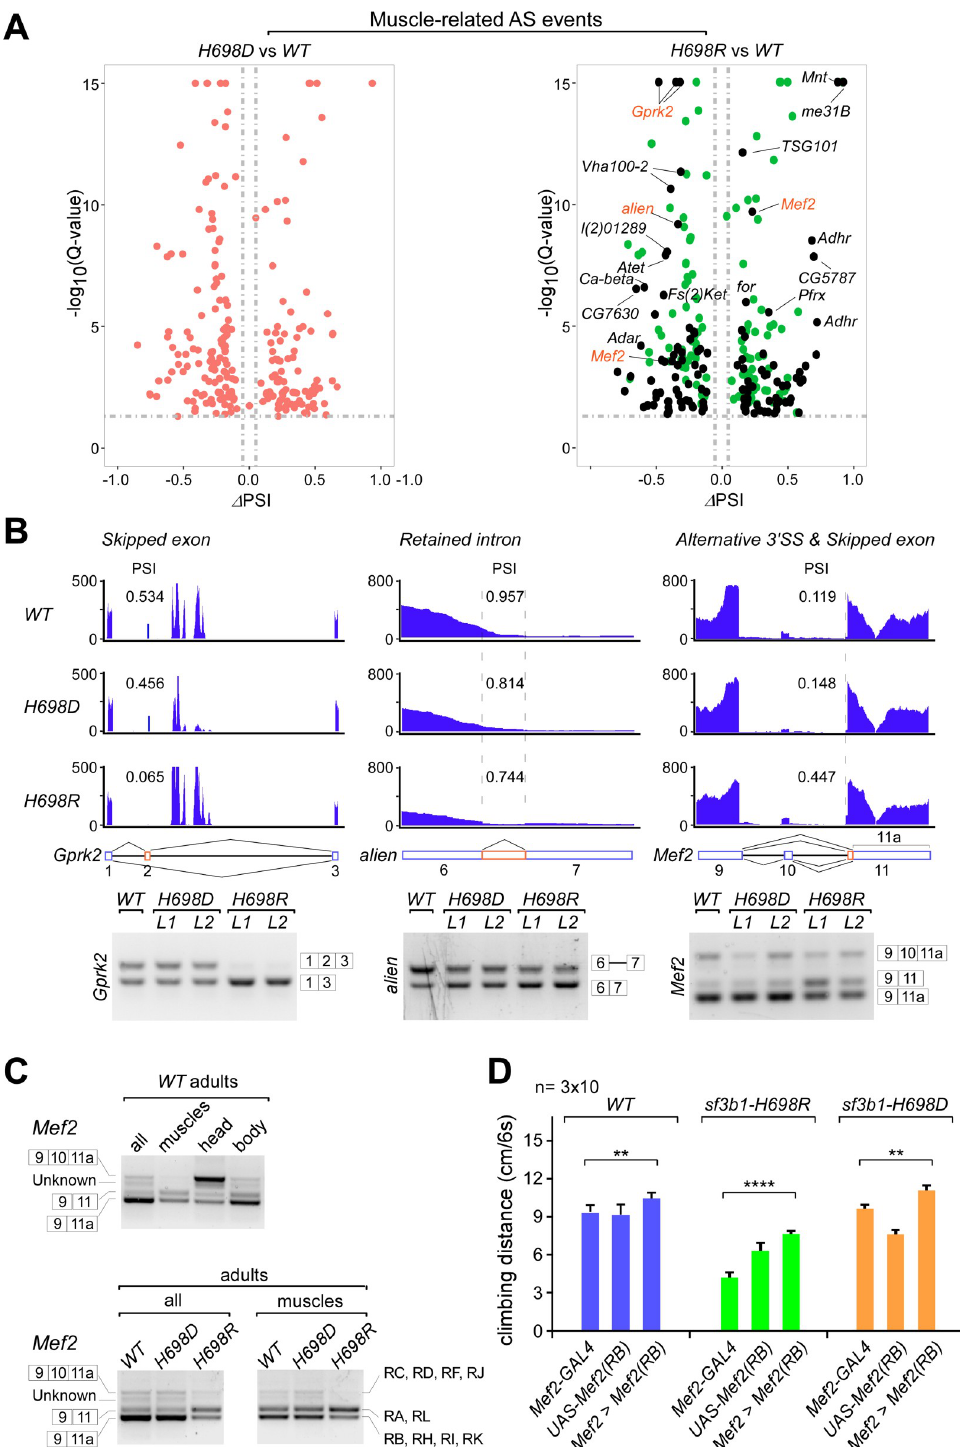
Fig 5. Alternative splicing changes involved in the muscle development in the H698R mutant. ( A ) Scatter plots of significant DS events involved in the muscle development in sf3b1 mutants. H698R -specifically changed AS events in the muscle-related genes were analyzed. DS events in H698D (red), H698R (green), and unique in H698R (black) are indicated in dots. ( B ) Validation of H698R -unique DS events by RT-PCR. PSI values for DS events (red rectangles) in each fly strain are indicated. ( C ) Tissue-specific AS events in Mef2 were changed in the H698R mutant. Whole